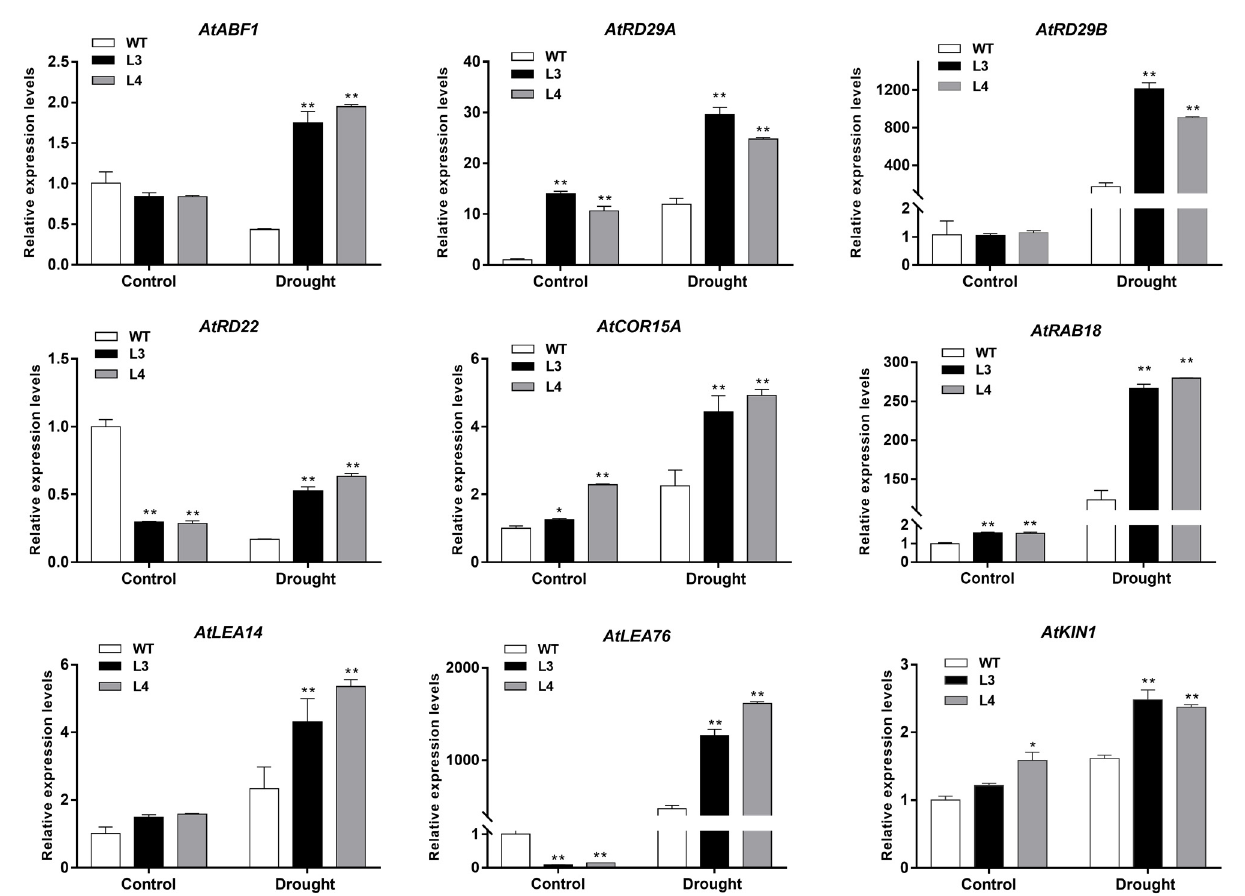
Figure 9. Expression levels of stress-responsive genes in WT and transgenic lines under drought stress. Error bars represent ± SD ( n = 3). Asterisks denote significant differences (as compared with the control group): * p < 0.05; ** p < 0.01.